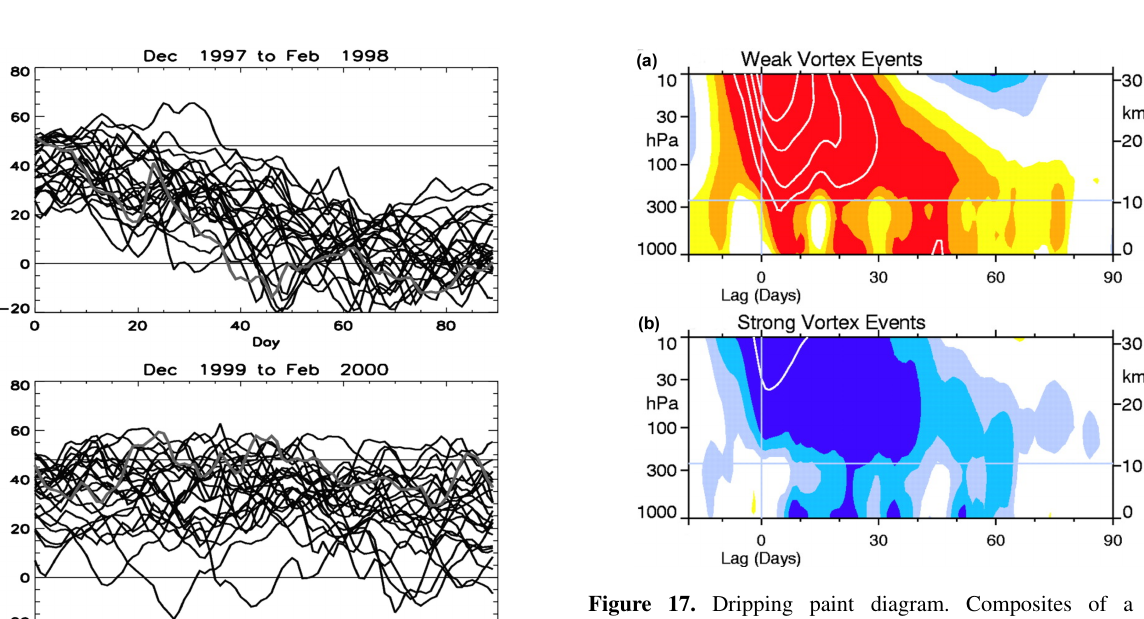
Figure 15. September-to-November mean anomalies in the zonal mean zonal wind at 10hPa and 60 ◦ S in ERA-Interim (solid curve) and hindcasts (black dots) initialized near 1 August. The dashed curve is the ensemble mean with the interannual correlation with the reanalysis of 0.73. Figure 2a from Seviour et al. (2014), ©Seviour et al. (2014), https://creativecommons.org/licenses/by/4.0/ (last access: 1 November 2022).